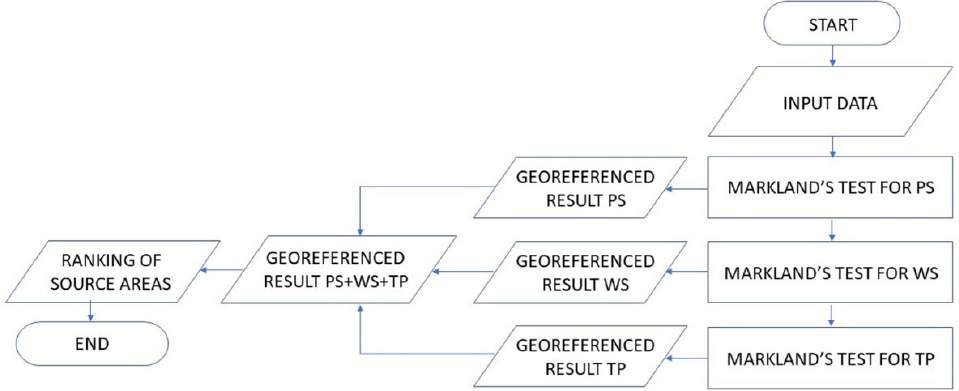
Figure 1. Diagram describing the general workflow the tool employs to perform its function.